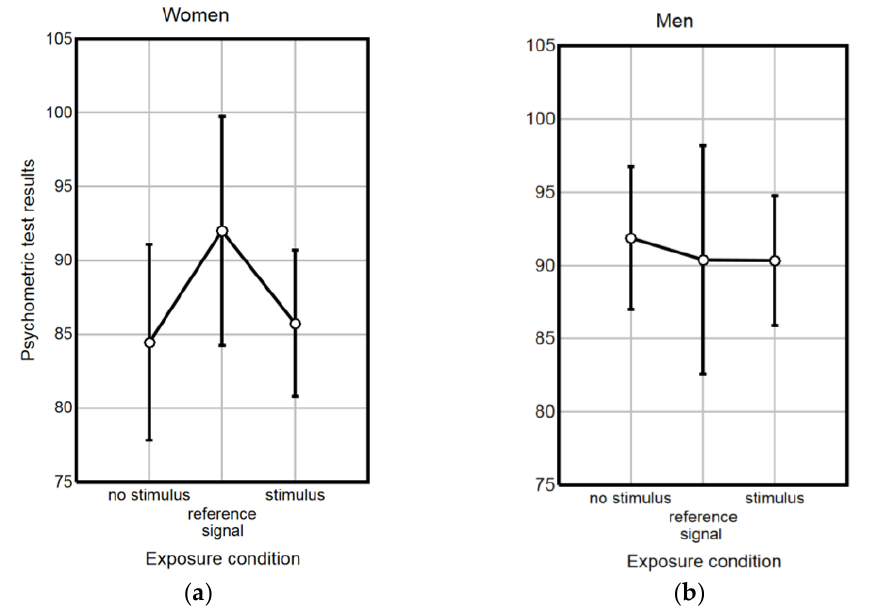
Figure 5. Results of the work under stress simulator test in various exposure conditions among ( a ) female and ( b ) male students. Data are given as mean values with 95% confidence intervals.